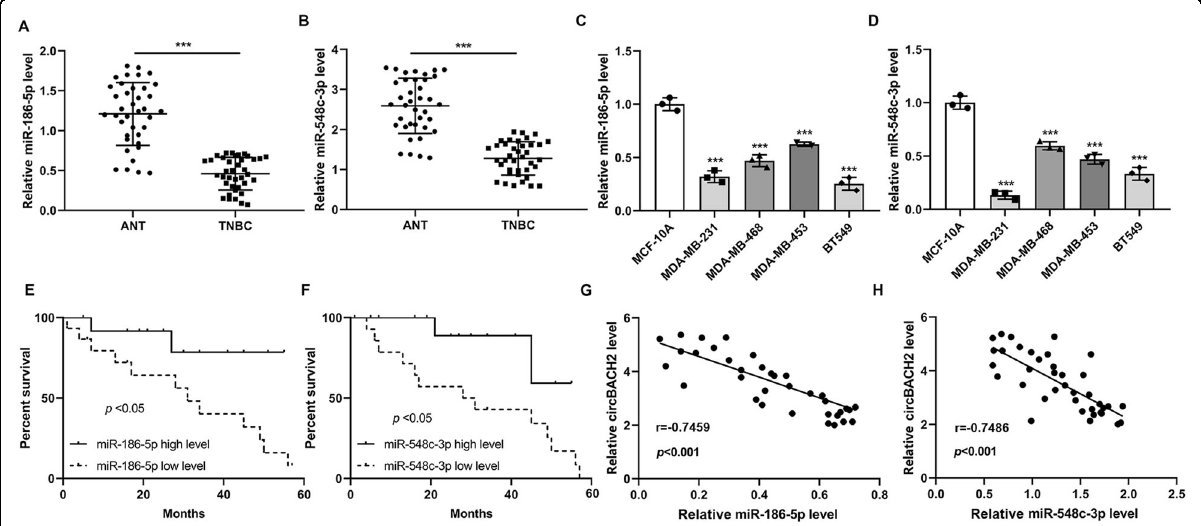
Fig. 5 miR-186-5p and miR-548c-3p were downregulated in TNBC tissues. The expression levels of A miR-186-5p and B miR-548c-3p in TNBC ( n = 38) and ANT tissues ( n = 38). *** P < 0.001. The expression levels of C miR-186-5p and D miR-548c-3p in the normal mammary gland cell line MCF- 10A and TNBC cell lines (MDA-MB-231, MDA-MB-468, MDA-MB-453, and BT-549). *** P < 0.001 vs MCF-10A. E , F The survival curve of patients with low/ high miR-186-5p/miR-548c-3p level. G , H The correlation between circBACH2 level and miR-186-5p/miR-548c-3p level in TNBC tissues ( n =